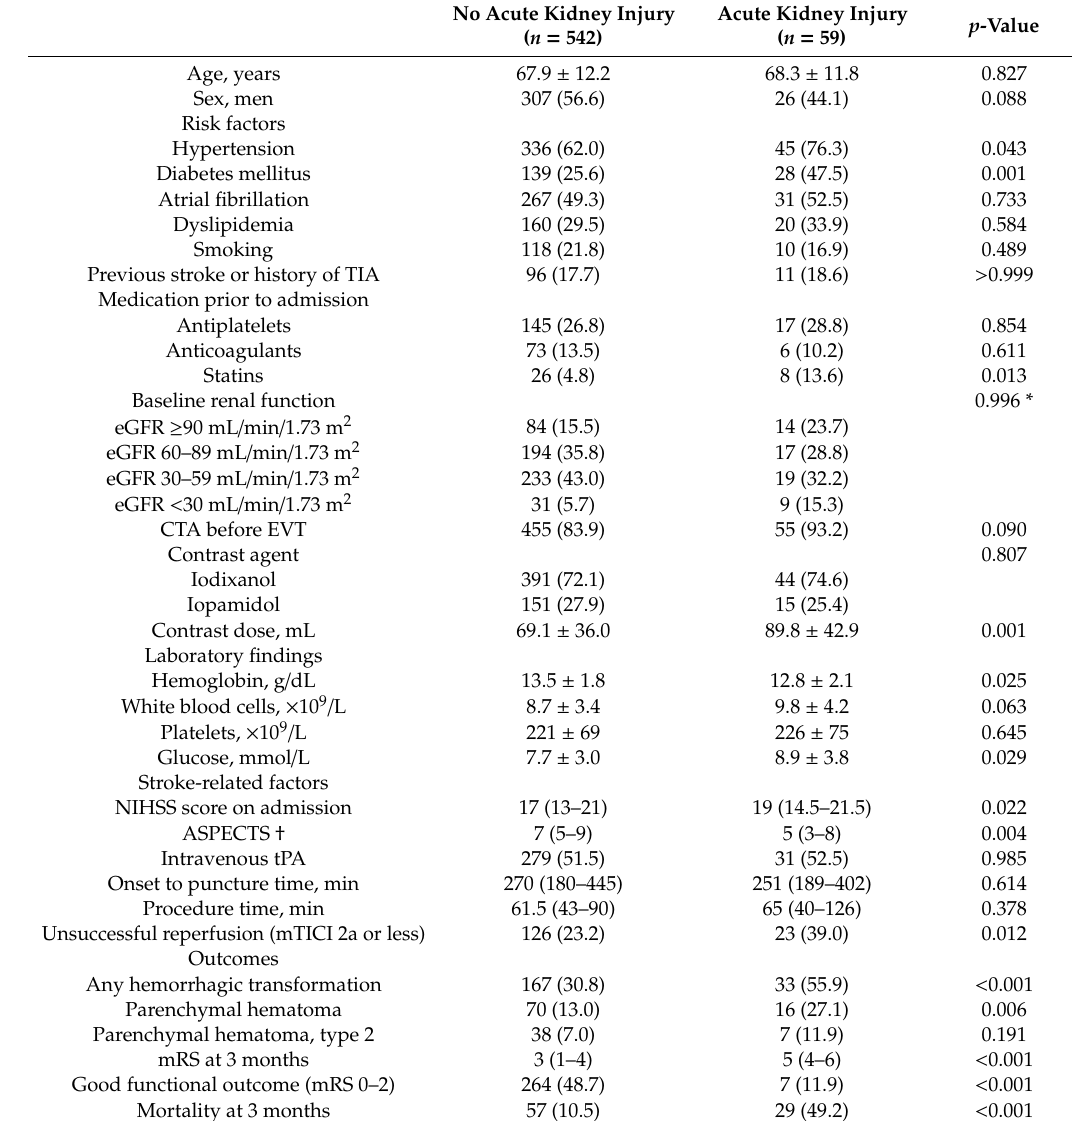
Table 1. Patient characteristics according to the presence of acute kidney injury.